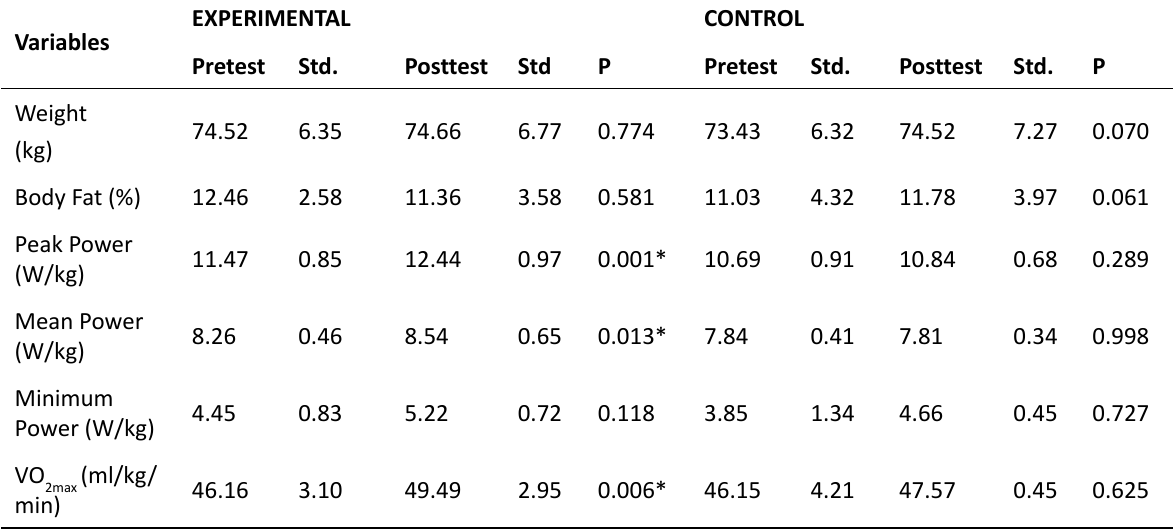
Table 2. Pre-test and post-test analysis results of the experimental and control groups EXPERIMENTAL Variables